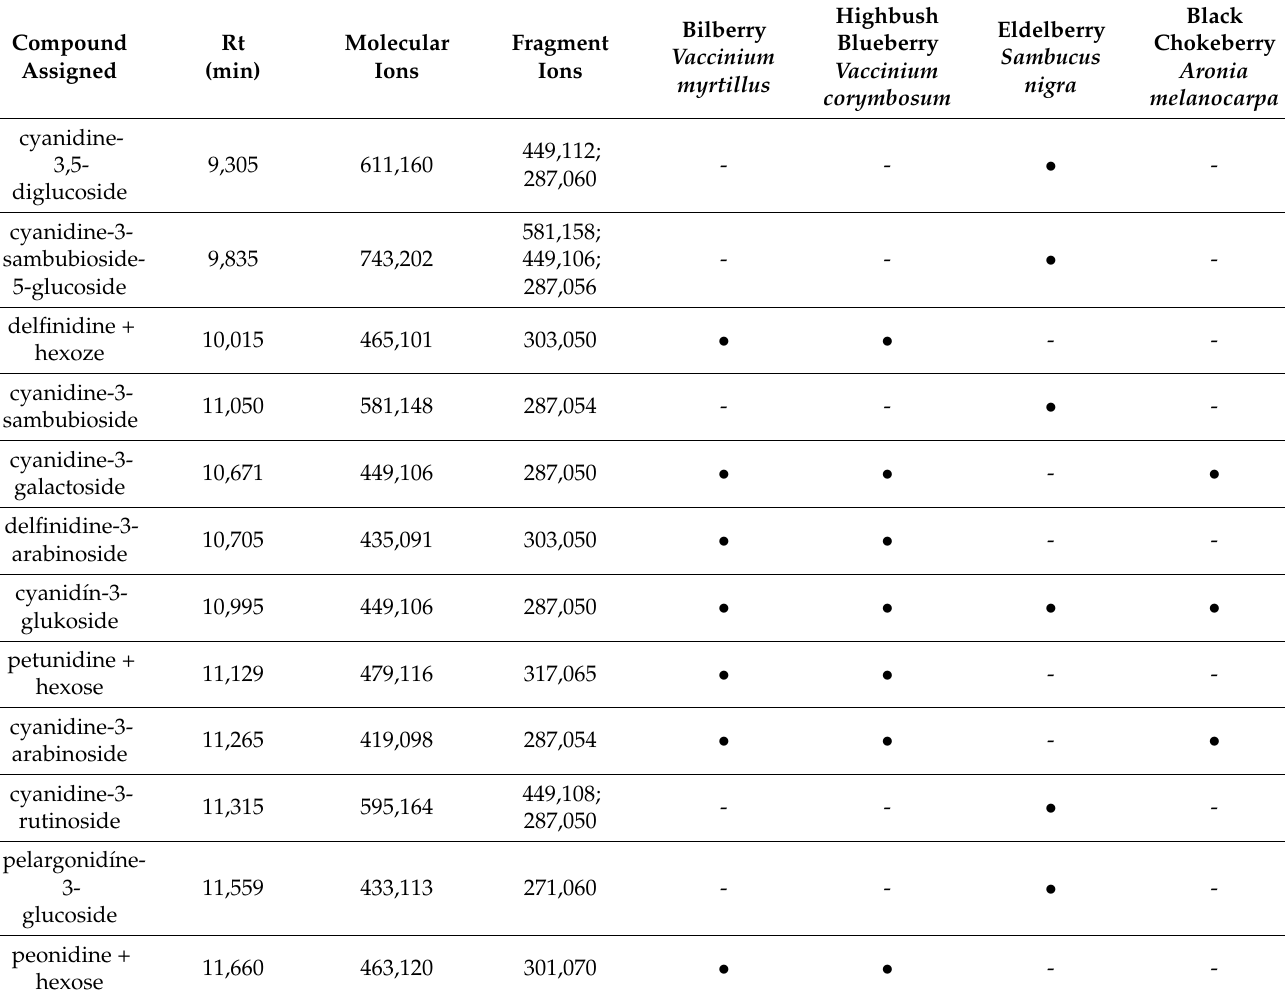
Table 2. Anthocyanin contents of elderberry lyophilizates in regard to acetone fruit extract ( • : presence; -: absence).